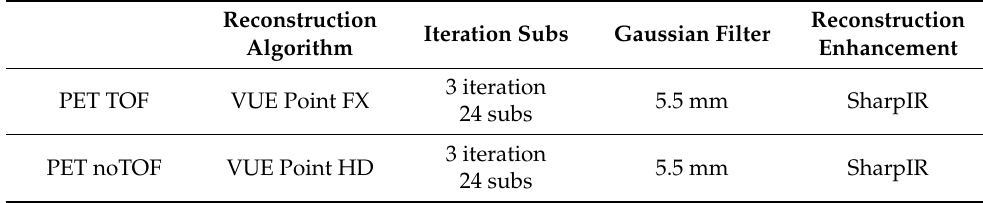
Table 3. Reconstruction parameters of the